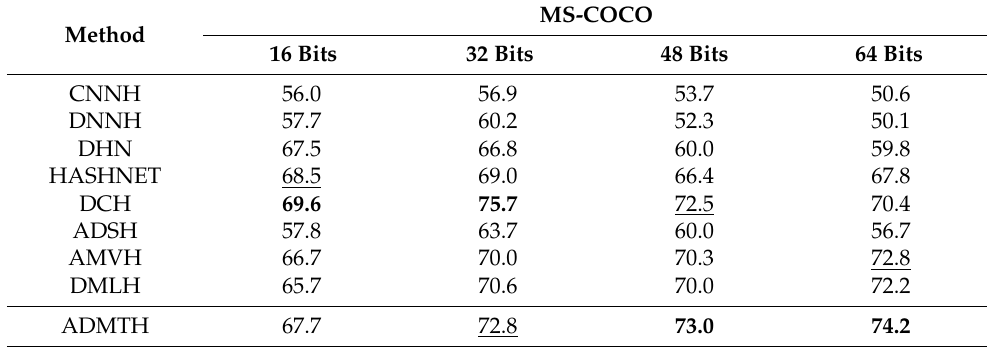
Table 5. Retrieval precision compared with baselines presented in MAP on MS-COCO.